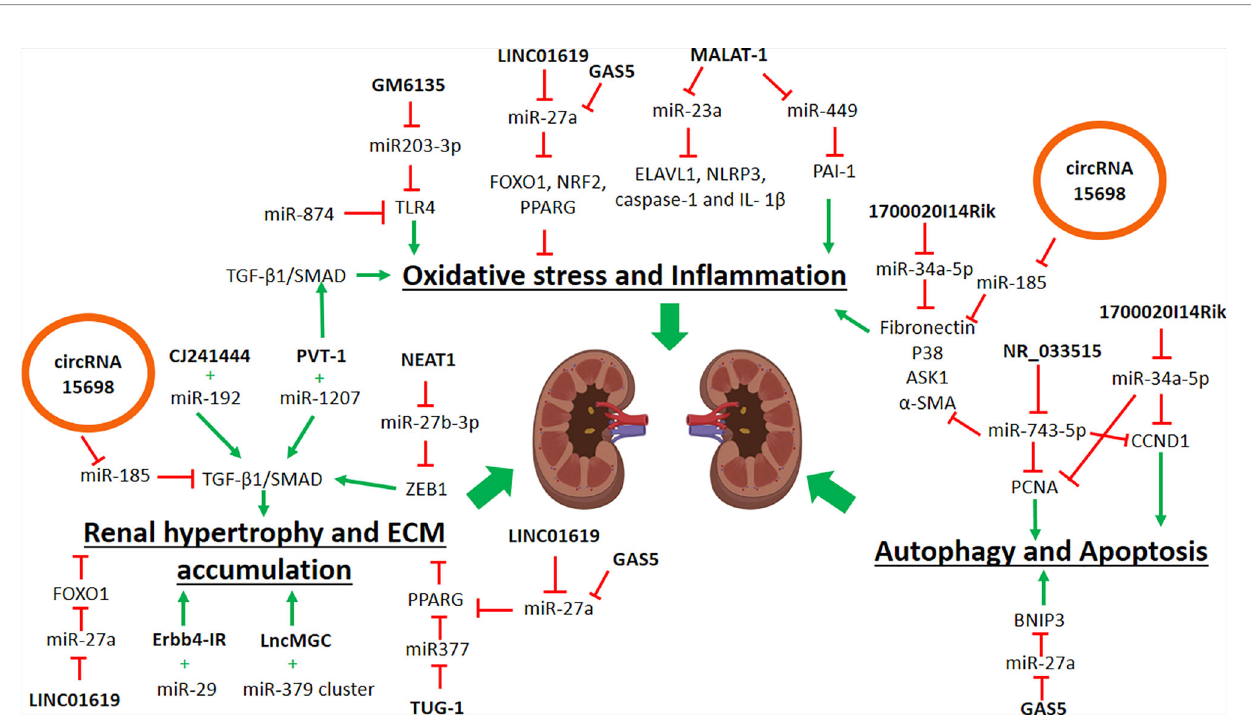
FIGURE 1 | Schematic diagram showing the roles of noncoding RNAs in contributing to diabetic nephropathy. ECM, extracellular matrix; ER, Endoplasmic reticulum; black arrow, positive regulation; red arrow, negative